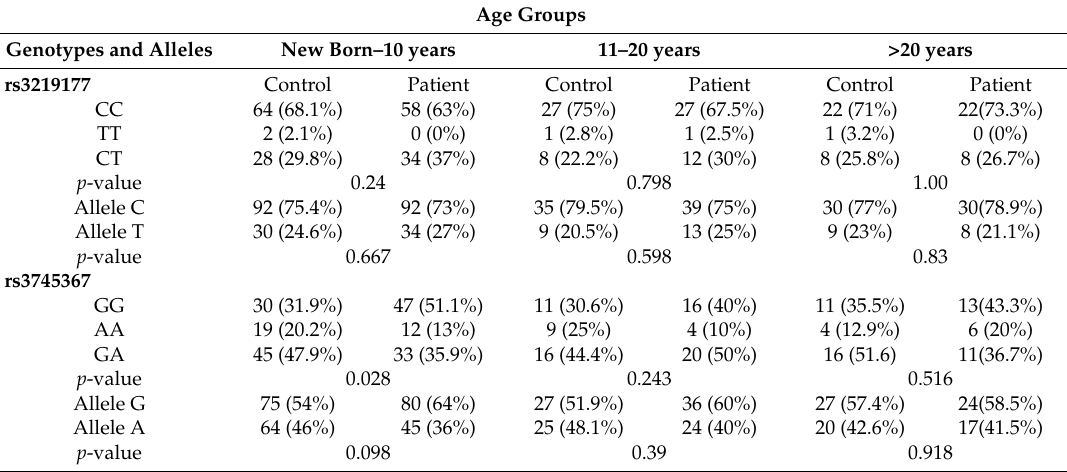
Table 6. The frequency of RETN genotypes and alleles among different age groups.